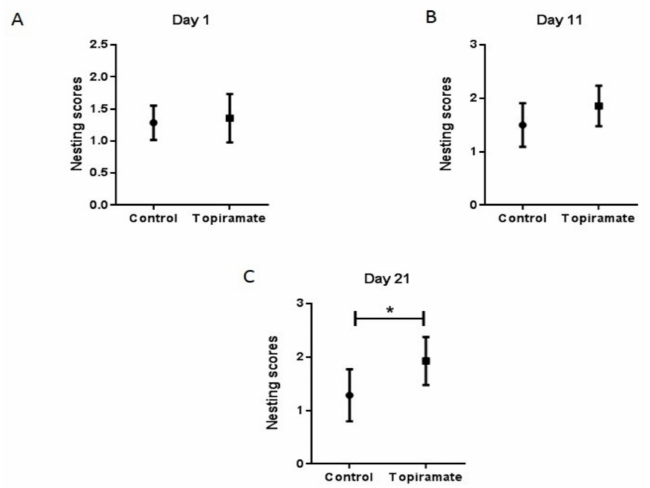
Figure 3. E ff ect of topiramate treatment on behavioral impairments (nest construction assay). APP /